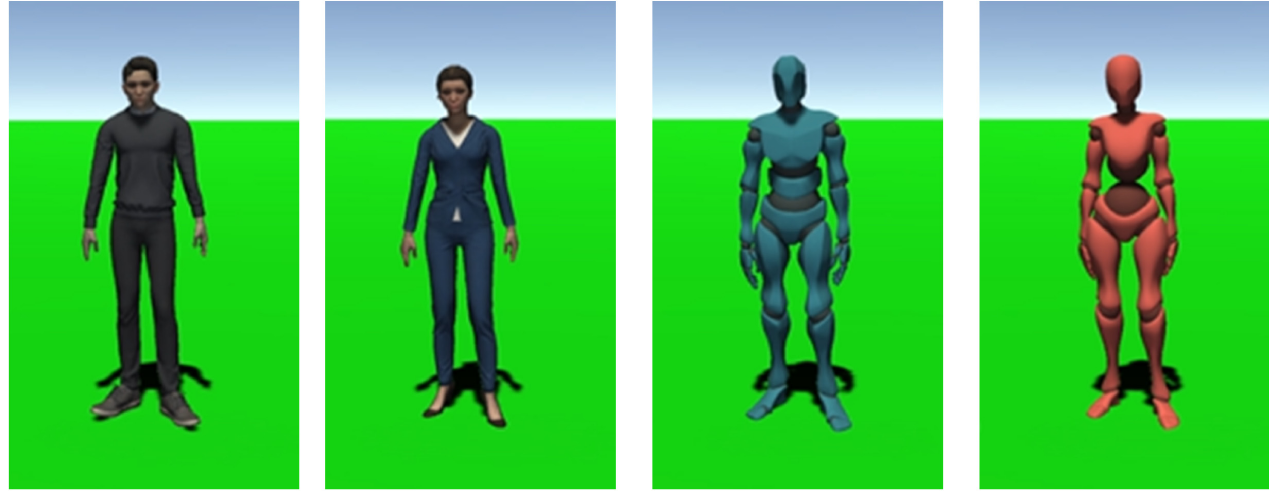
Fig 3. Appearance of each virtual agent. We used four different agents in the experiment. (a) human-like man, (b) human-like woman, (c) robot-like man, (d) robot-like woman.